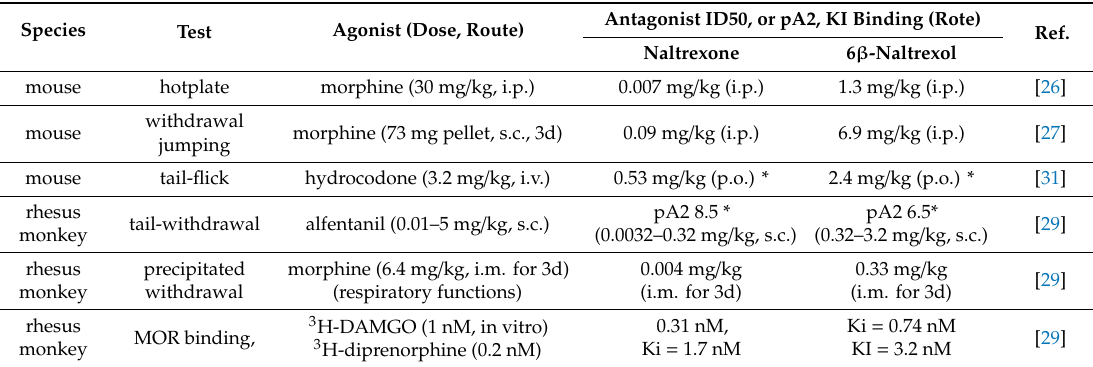
Table 1. Relative potency of naltrexone and 6BN in vivo. Data are from publications that compare naltrexone with 6BN, with regards to opioid antinociception or causing withdrawal in opioid-dependent animals, and in vitro MOR binding in rhesus monkey cortical brain homogenates.